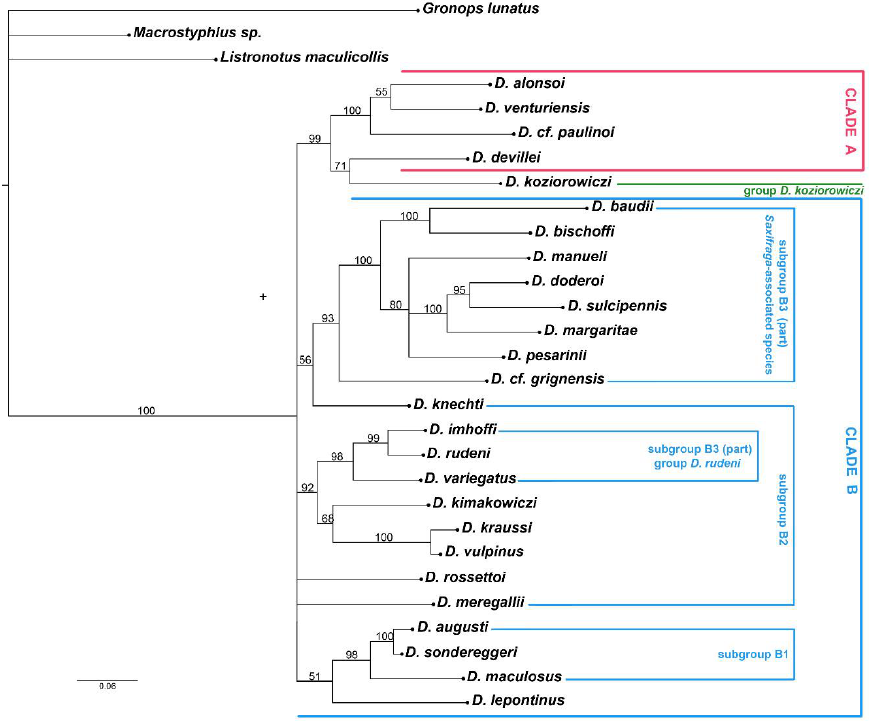
Figure 7. Mitochondrial cytochrome oxidase I analysis, Dichotrachelus . Bayesian Inference consensus tree (50% majority rule). Numbers above branches indicate posterior probability. Scale bar unit: expected substitutions per site. Clades and species group are indicated as shown by the Bayesian analysis based on morphology.